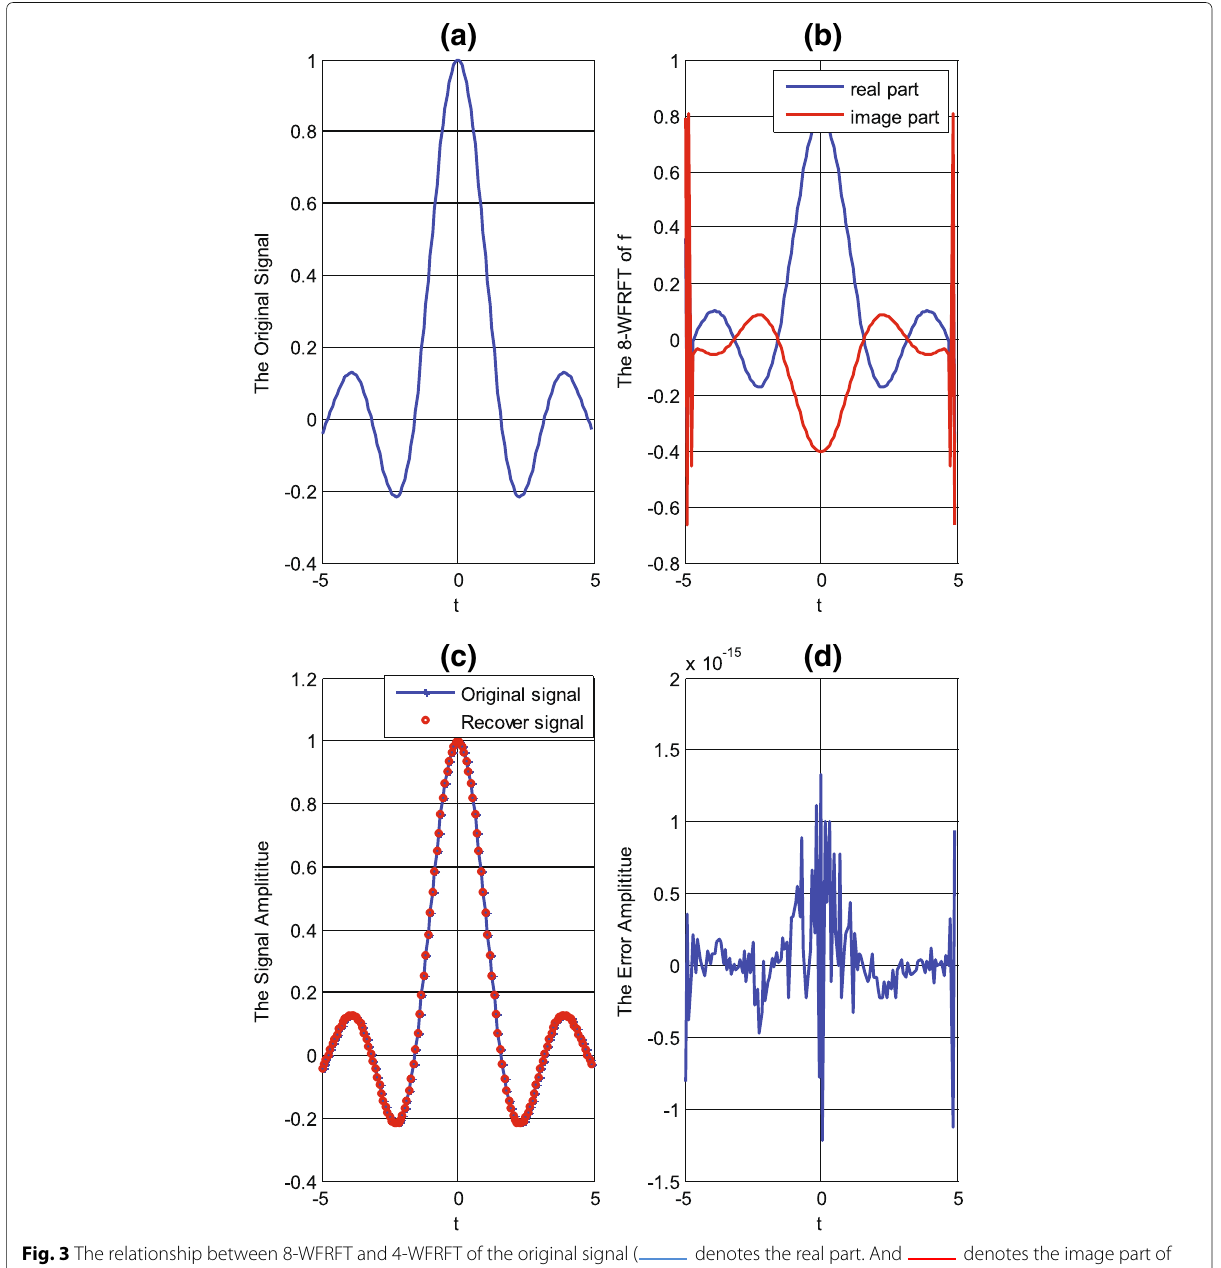
Fig. 3 The relationship between 8-WFRFT and 4-WFRFT of the original signal ( denotes the real part. And denotes the image part of 8-WFRFT signal. Moreover, is the original signal and is the recover